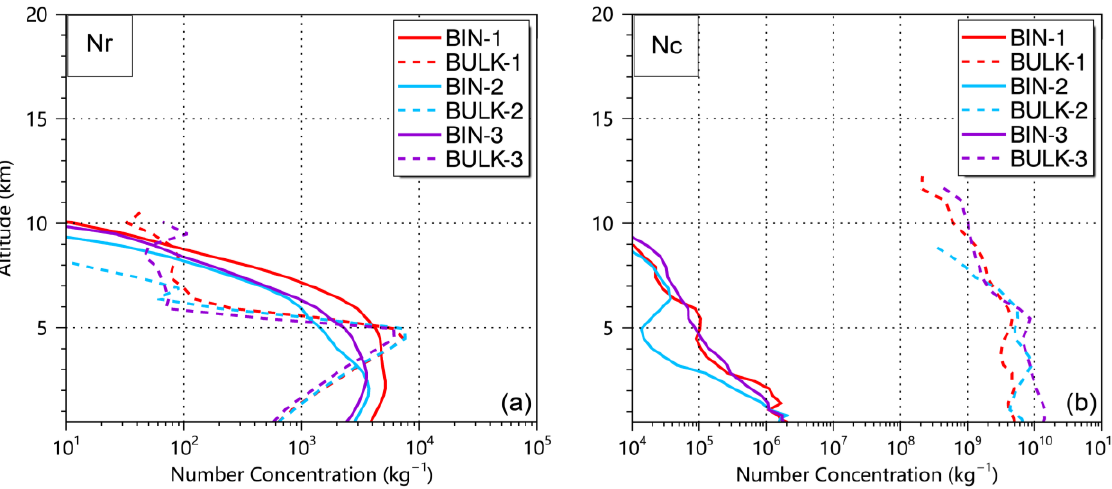
Figure 12. Domain-averaged vertical profiles of ( a ) raindrop and ( b ) cloud droplet number concen- tration (kg −1 ) during three different periods of typhoon landfall. The symbol Nx (x = r, c) represents the number concentration of each hydrometeor species, and the appending digits -1, -2, and -3 in the legend represent the periods before, during, and after landfall, respectively.